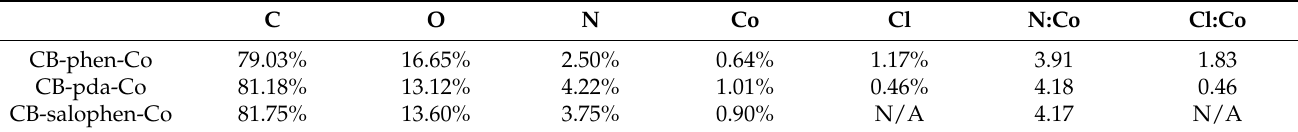
Table 1. Atomic composition (in percentage) of CB conjugated Co complexes detected by